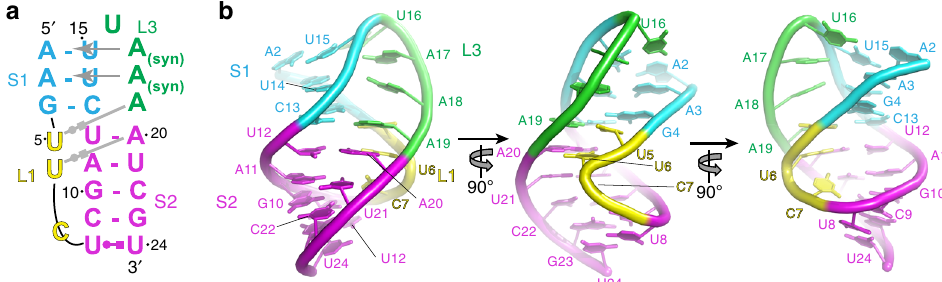
Fig. 6 Structure of the UPD. a Secondary structure diagram of the UPD, colored by element (colors do not match Fig. 5) and labeled. Grey arrows indicate where bases interact with the minor grooves and non-canonical base pairs are shown. b Structure of the UPD in ribbon representation, colored to match a . Nucleotides are numbered